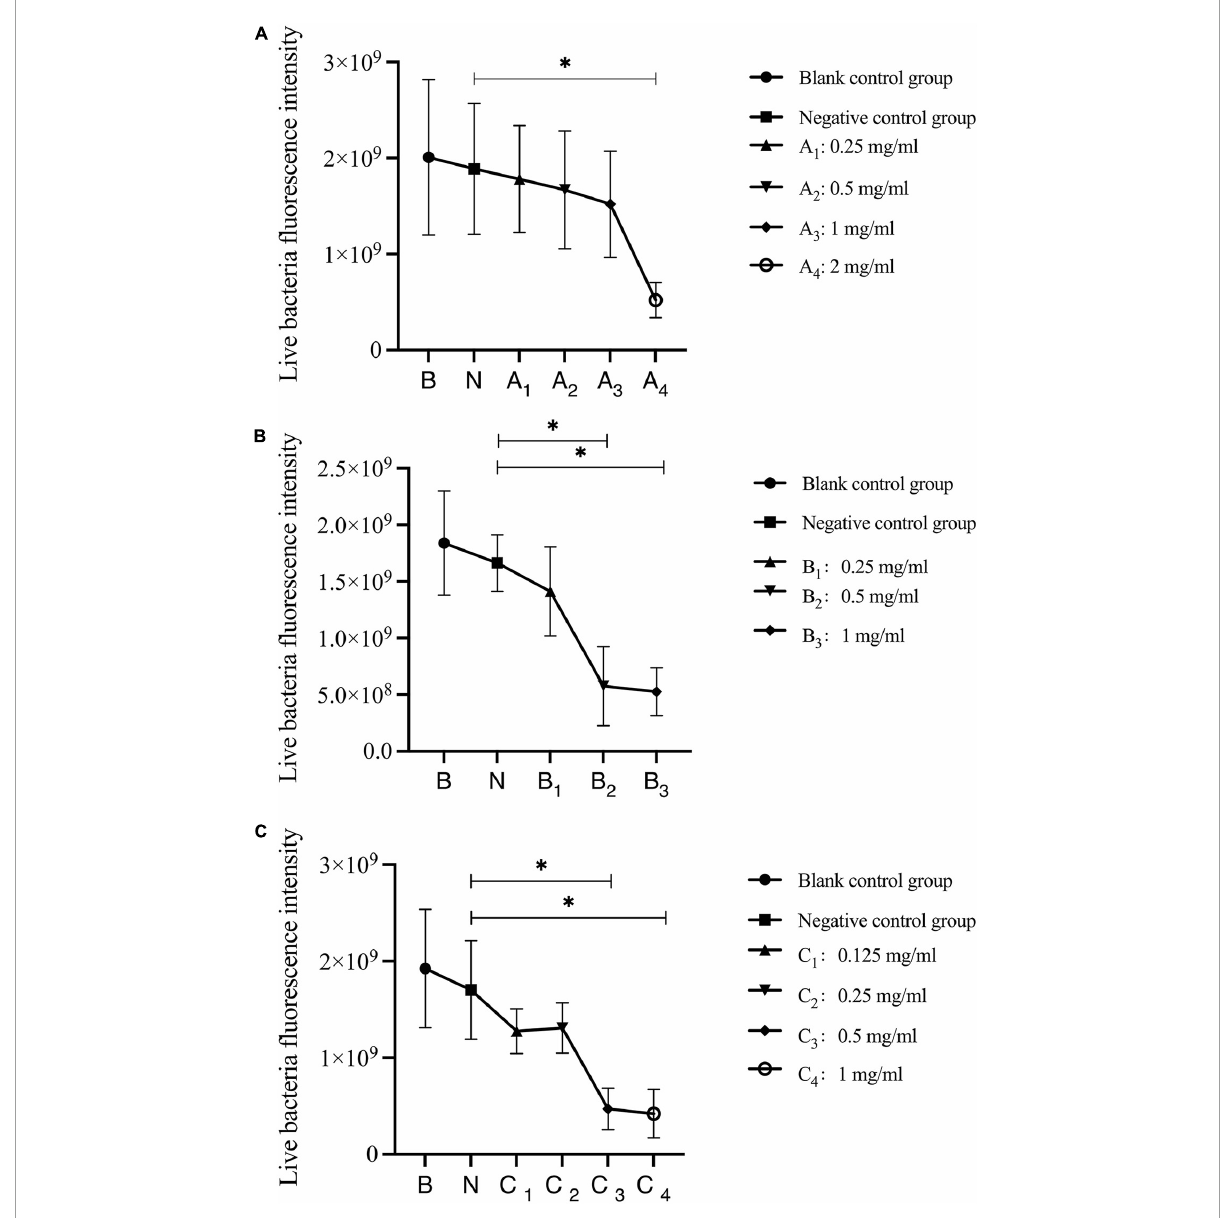
FIGURE6 Quantitative analysis of live bacteria in biofilms after bovine trypsin treatment for 30 s, 1 min, and 3 min. (A–C) Show the quantitative analysis of biofilm live bacteria after 30 s, 1 min, and 3 min of bovine trypsin treatment, respectively. ∗ Indicates that there is a statistically significant difference compared with the negative control group ( P <